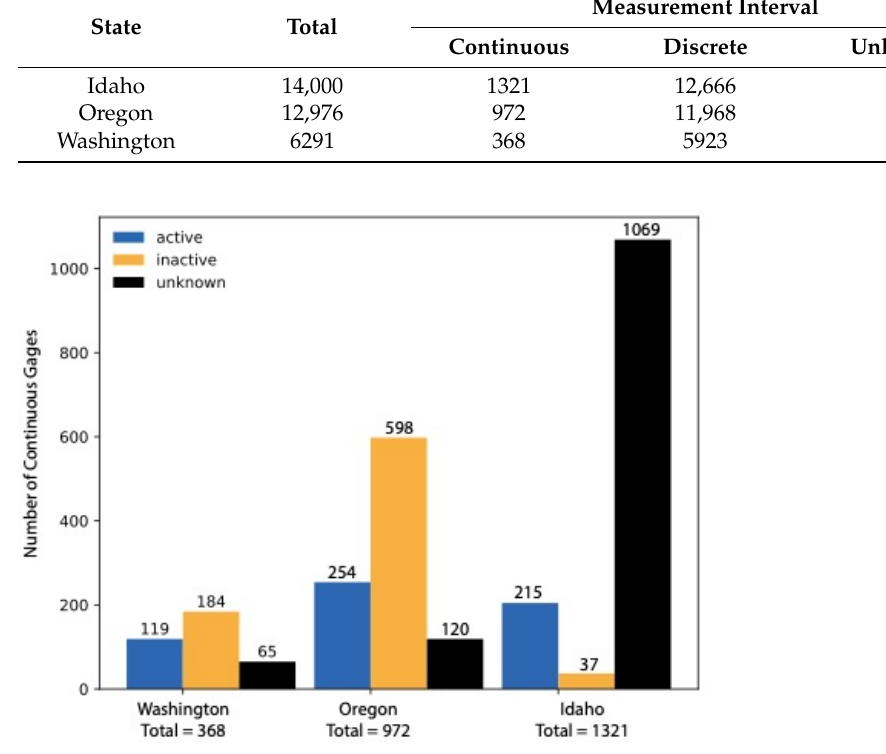
Figure 4. Streamflow monitoring location status (active, inactive, or unknown) for each continuous monitoring location in each state.